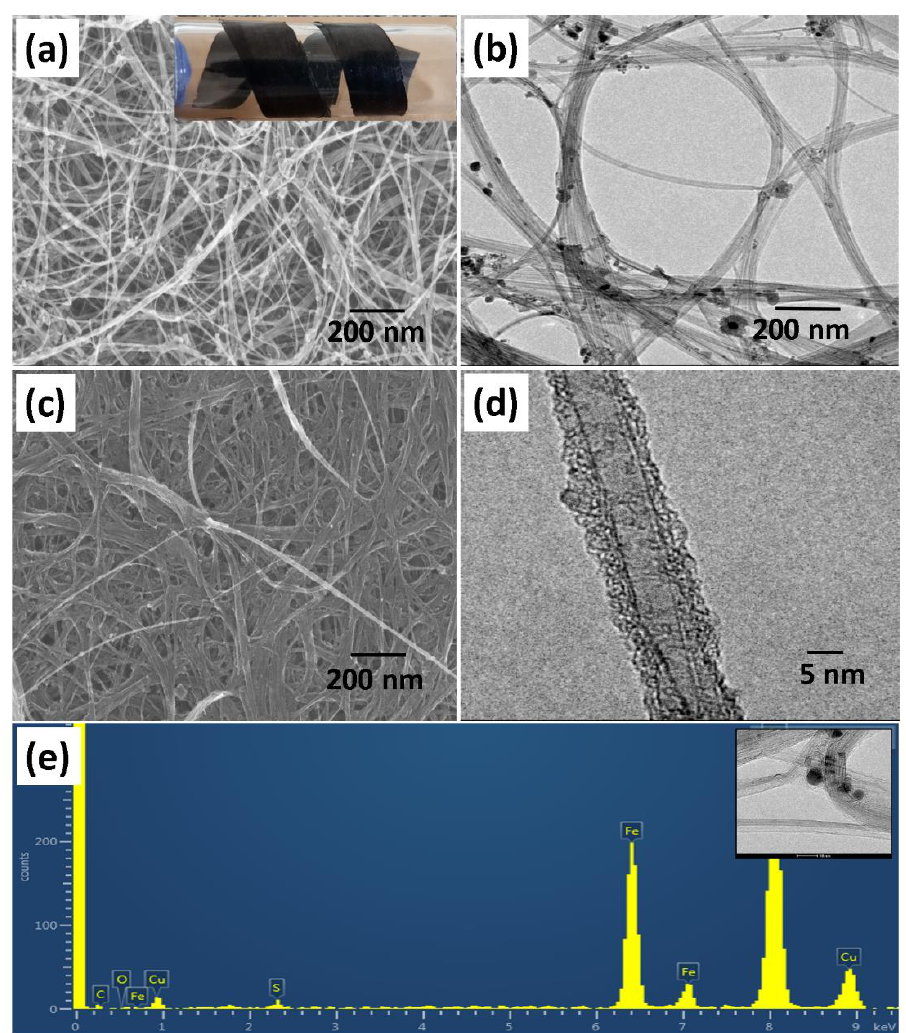
Figure 2. SEM image of pristine CNT (photograph of a flexible CNT in inset) ( a ); TEM image of pristine CNT ( b ); SEM image of p-sulfonated poly(allyl phenyl ether) (SPAPE)-coated CNT and ( c ) TEM image of SPAPE-coated CNT ( d ); and EDS spectra of pristine CNT (the inset is the corresponding TEM image) ( e ).